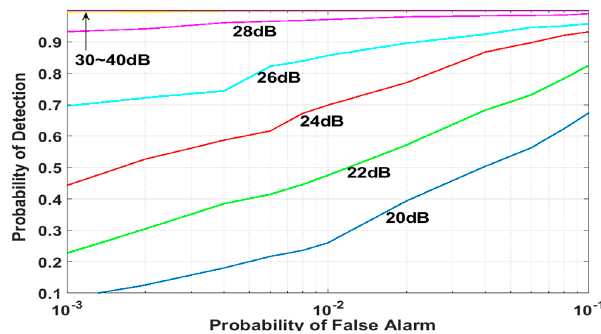
Figure 10. Probability of detection obtained for the proposed DM method (C/N 0 ): 33-chip delay.